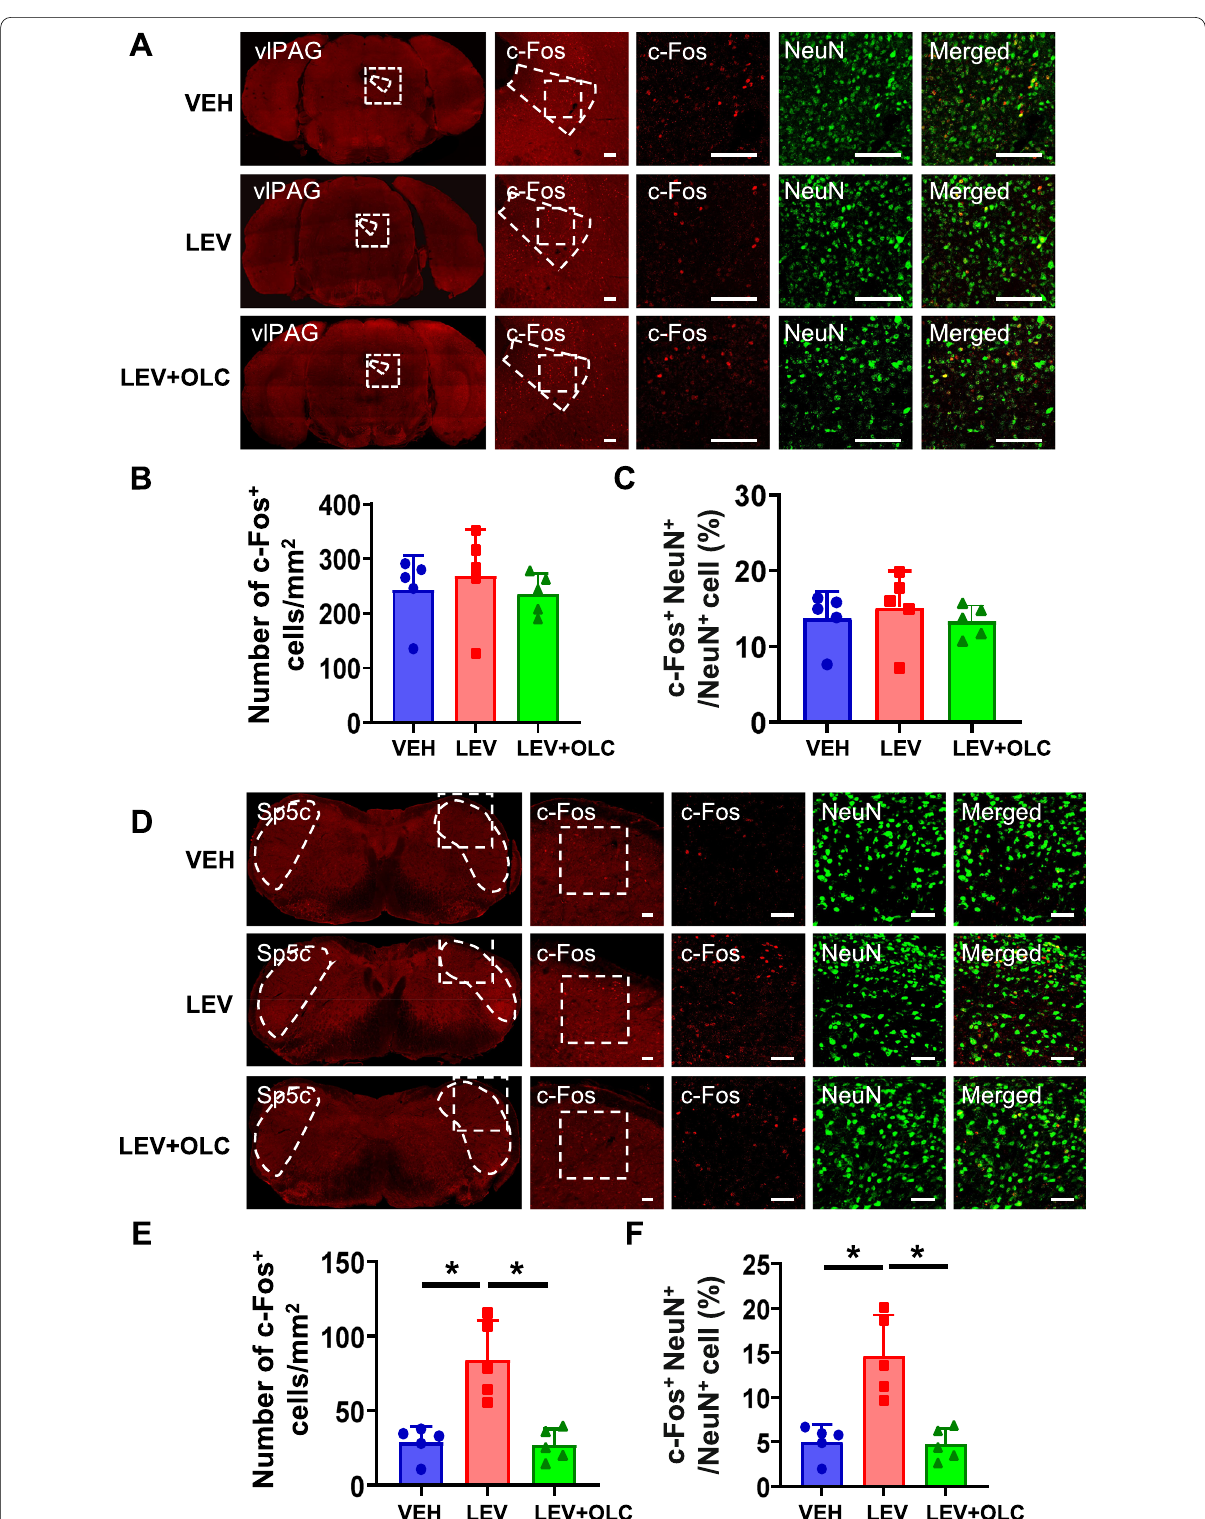
Fig. 8 (See legend on previous